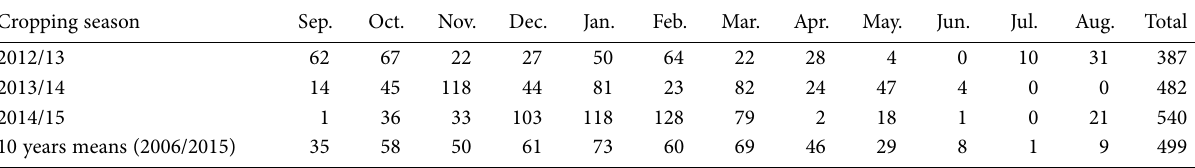
Table 1. Monthly rainfall (mm) recorded during the 2012/2013, 2013/14 and 2014/15 cropping seasons at Bou Salem, Tunisia. Cropping season